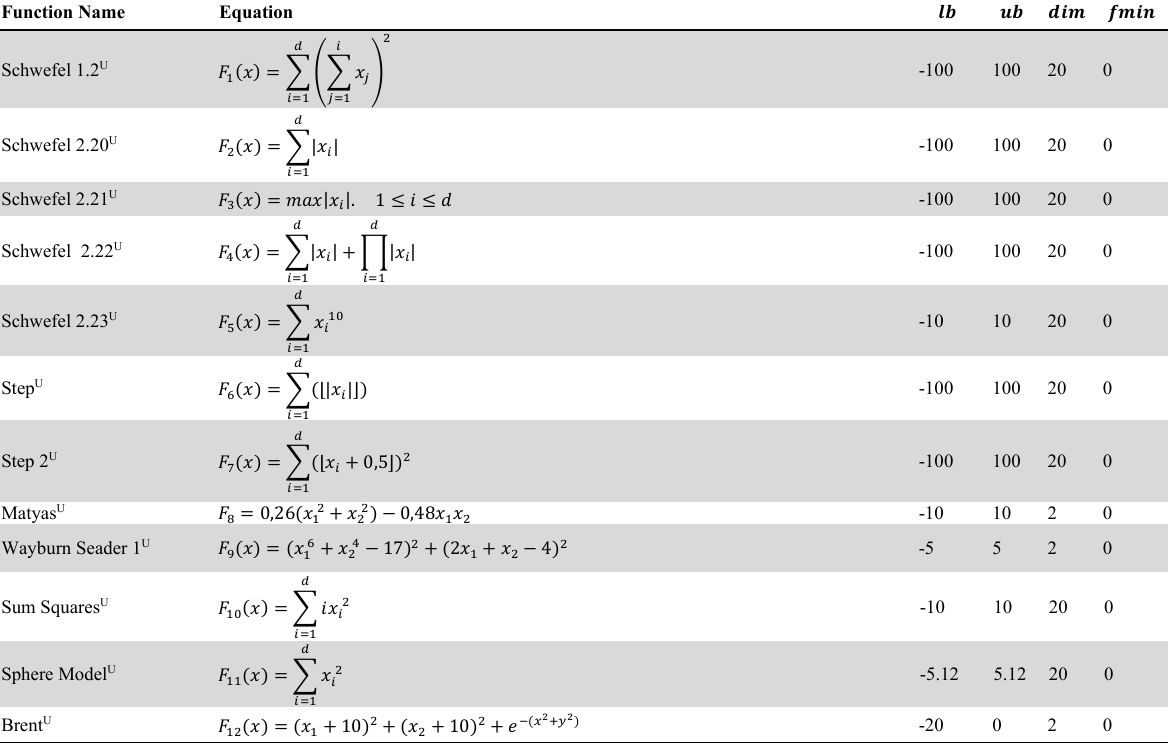
Benchmark functions used in the